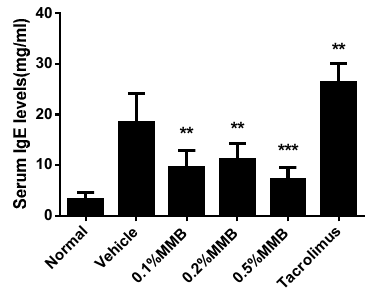
Figure 3. The total IgE levels in mice serum of different groups. Values are mean ± SD ( n = 6). ** p < 0.01, *** p < 0.001 versus the vehicle group.